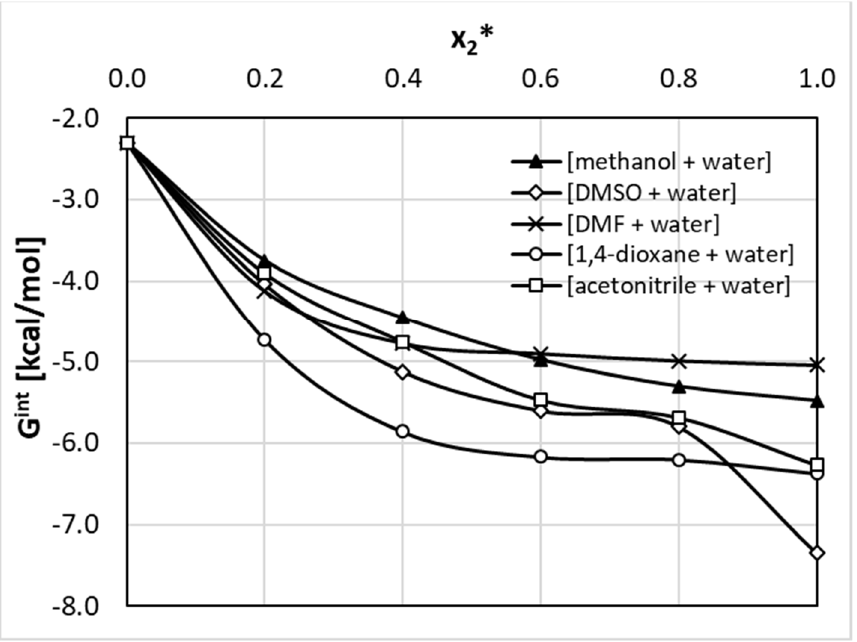
Figure 8. Predicted solubility of nicotinamide confronted with experimental data.